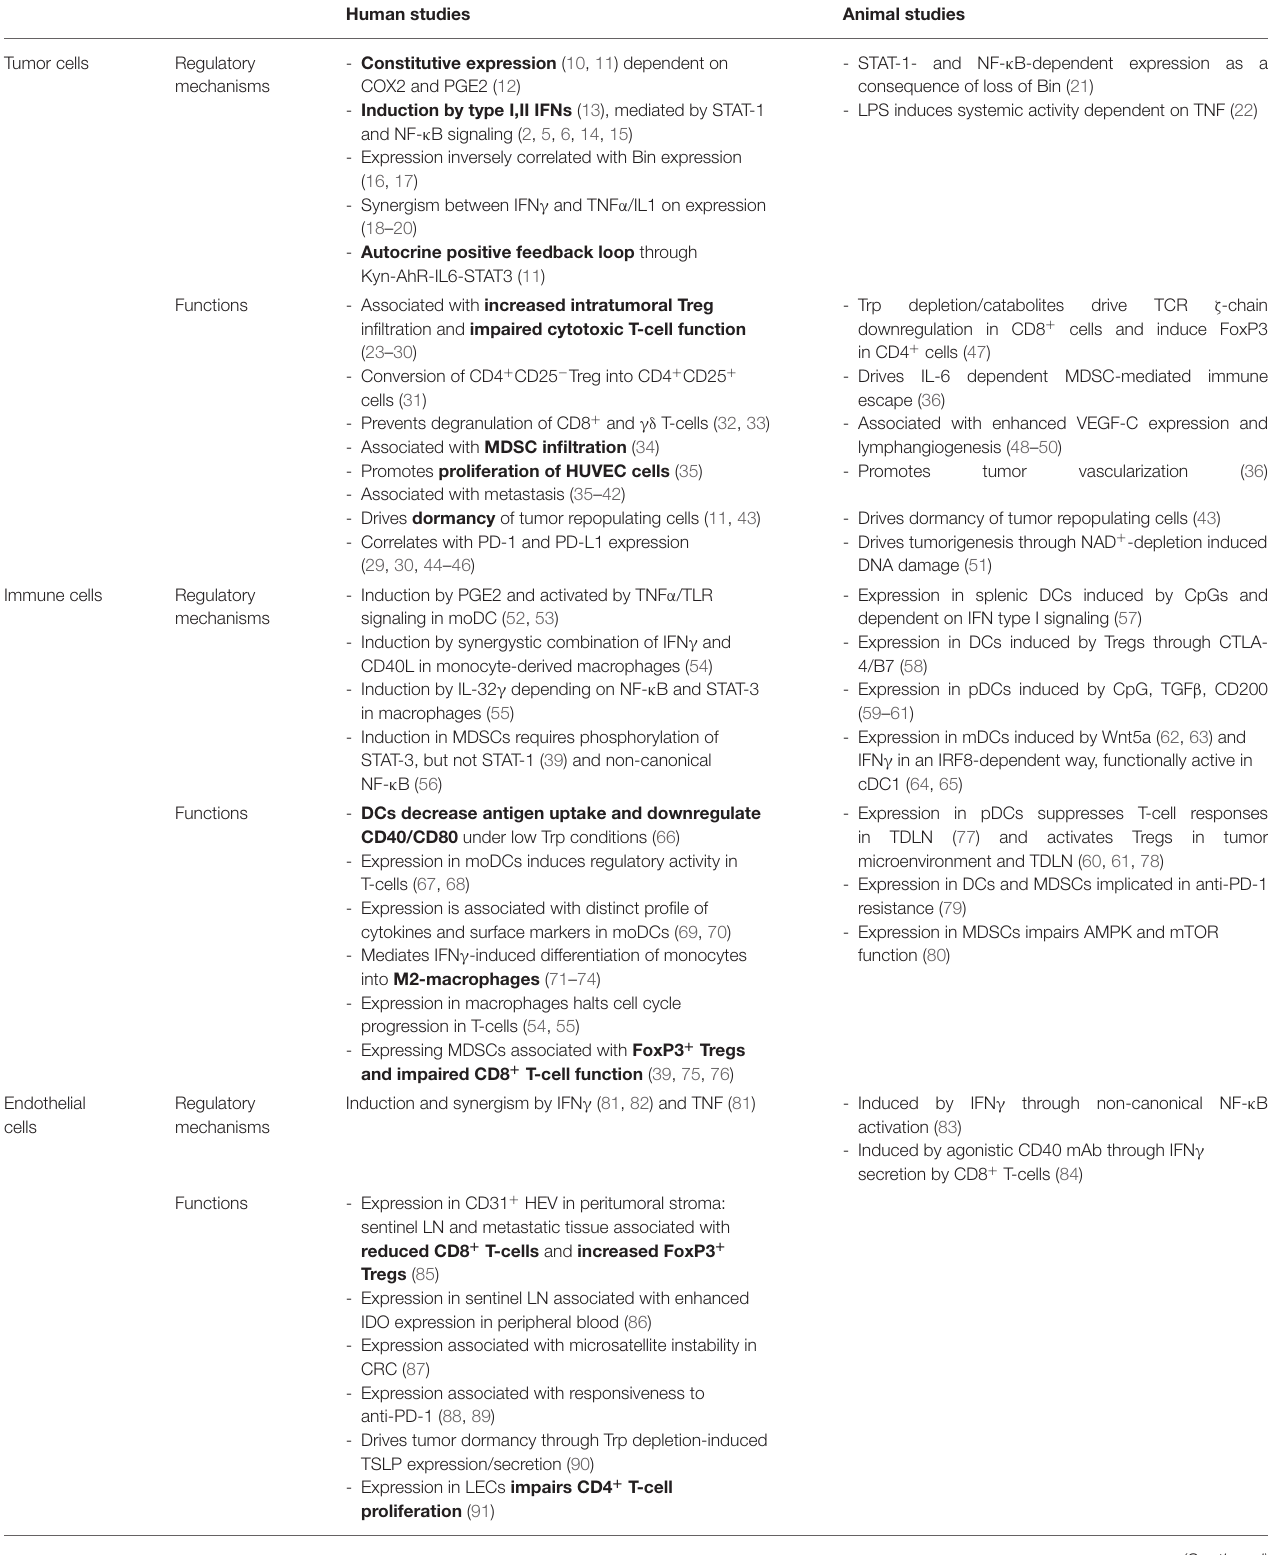
TABLE 1 | Regulatory mechanisms and functions of IDO expressing cells in the tumor